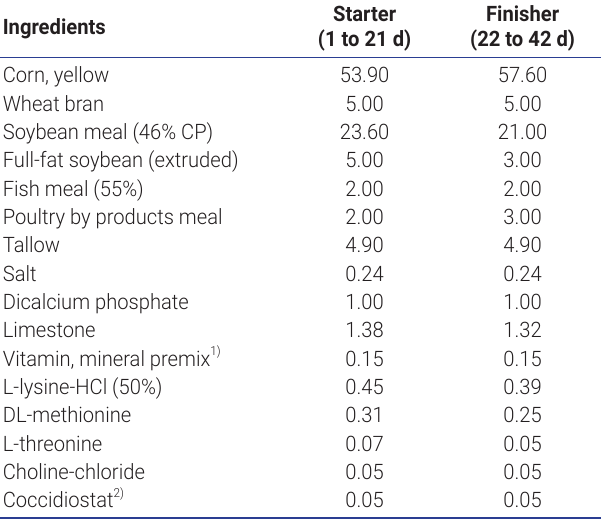
Table 1. Composition of the basal diets for trials 1 to 4